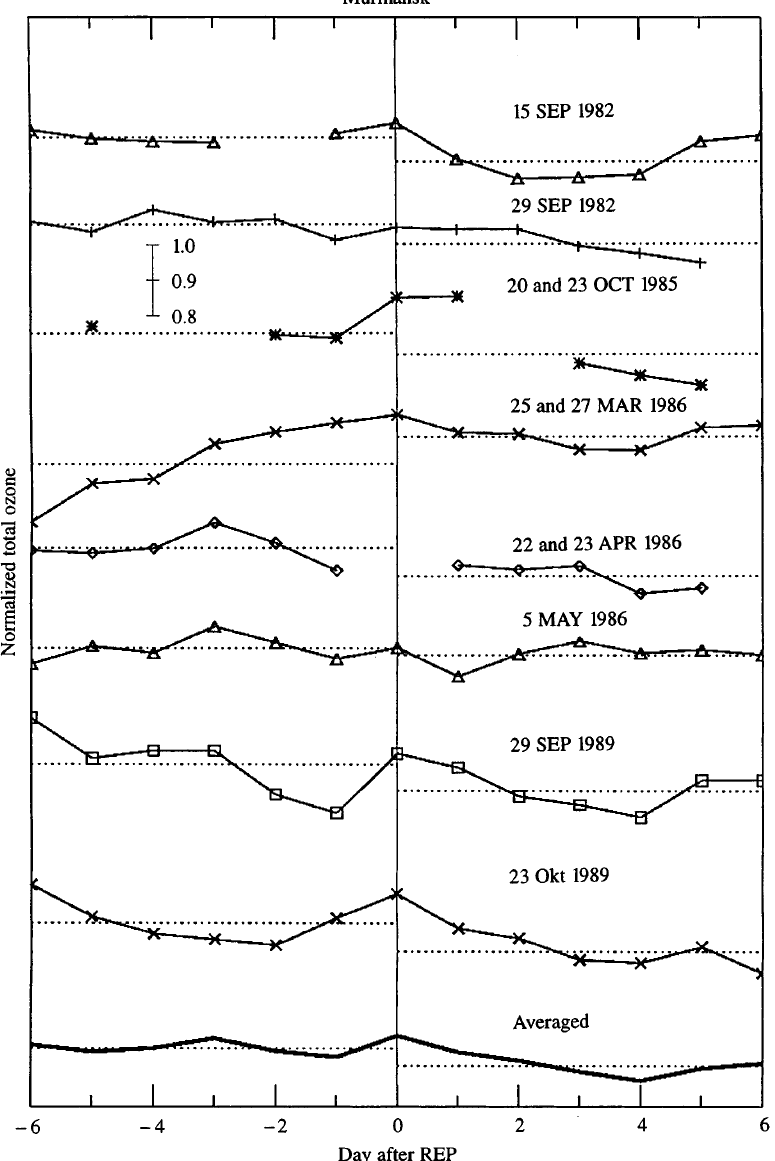
Fig. 2. The normalized ozone variations in Mur- mansk before and after REP events. The dotted lines are mean values. The bottom curve is an average of all